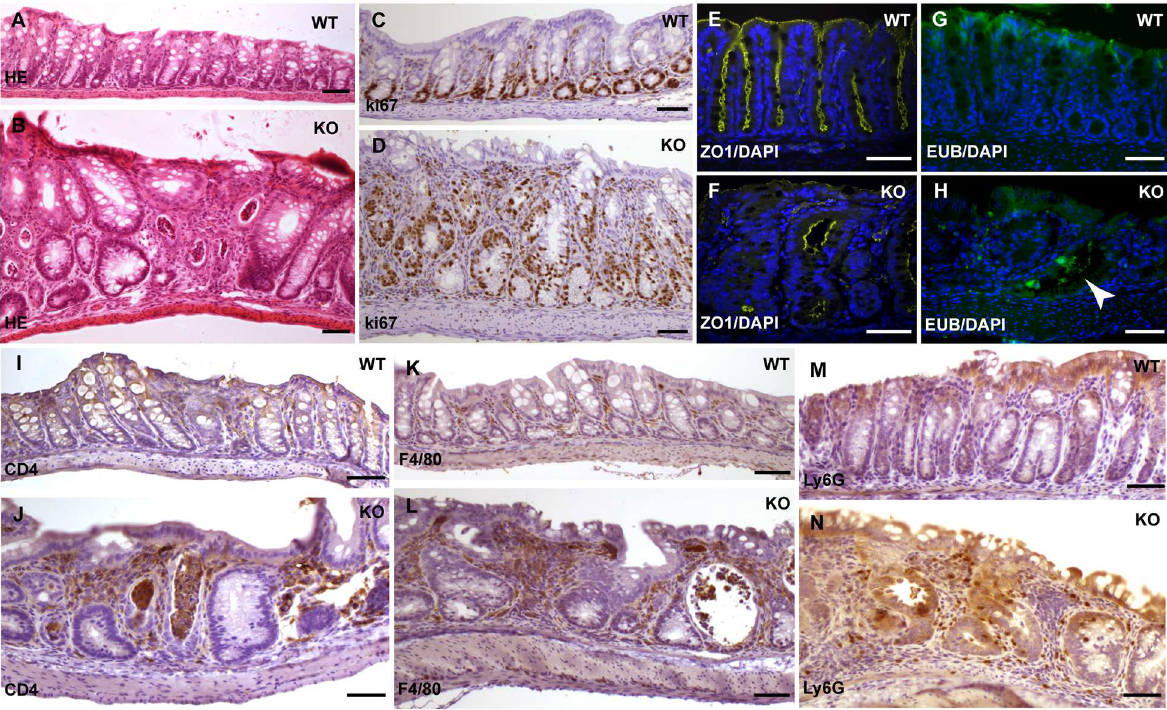
Fig 5. The IEC-specific hnRNPI knockout mice develop severeinflammation at P14. (A) and (B) HE–stainedsections show the severely inflamedcolonicepitheliumin the knockout mice at P14 (B). (C) and (D) Immunohistochemicalstaining with an anti-Ki67 antibody shows hyperproliferationof the colonicepitheliumin the knockout mice. (E) and (F) Immunofluorescence staining with an anti- ZO1 antibody shows impaired tight junctionsin the colonicepitheliumof the knockout mice. (G) and (H) FISH with a universaleubacterial probe shows bacteria infiltrationin the colonicepitheliumof the knockout mice (arrowheadin H). Nuclei were counterstained with DAPI in E to H. (I) to (N) Immunohistochemicalstainingwith indicatedantibodiesshows increasednumber of inflammatory cells in the lamina propriaof the knockout mice. (I) and (J) show CD4 positive T-cells, (K) and (L) show macrophages, (M) and (N) show neutrophils.WT, wild-type;KO, knockout. Scale bars, 50 μ m.